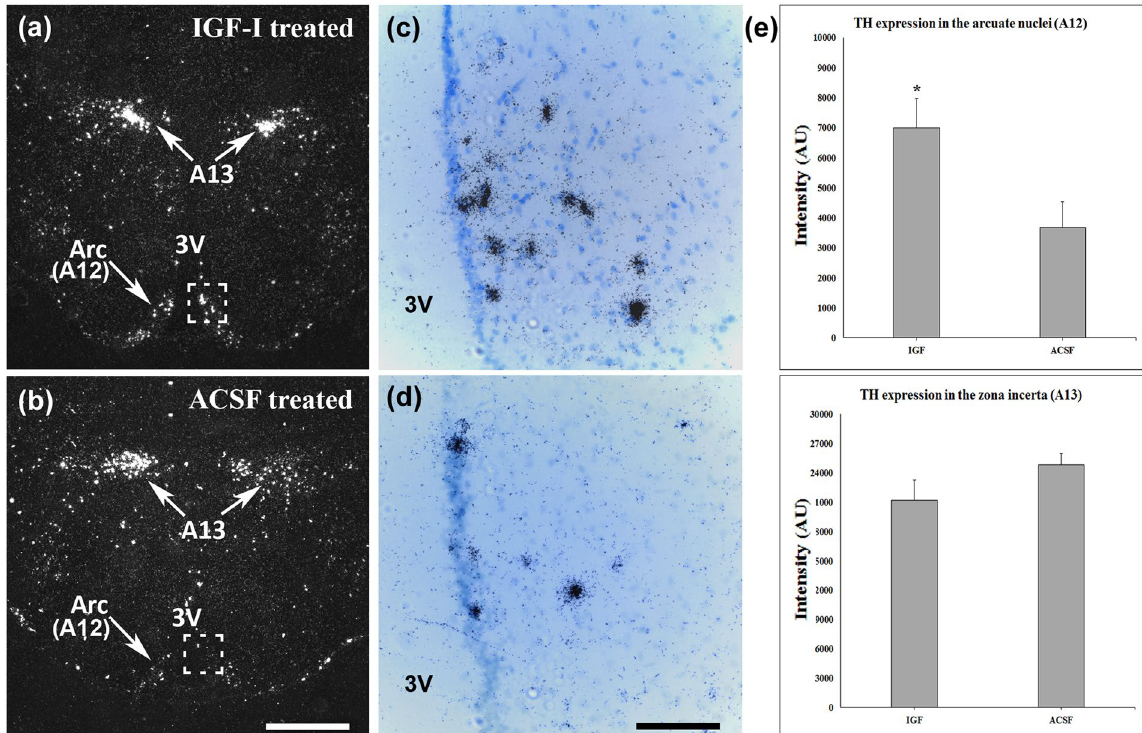
Figure 6. I.c.v. IGF-I administration enhanced the expression of TH in the arcuate nucleus. ( a,b ) The brains of IGF-I- and ACSF-treated rat mothers (n = 4 in both groups) were used for in situ hybridization histochemistry. Dark-field photomicrographs show that TH mRNA expression (white dots) was abundant in the zona incerta (A13 dopamine cell group) and the arcuate nucleus (A12 dopamine cell group) in IGF-I treated mothers. Without IGF-I, however, TH mRNA levels are low in the arcuate nucleus and are abundant in the zona incerta. ( c,d ) High magnification bright-field photomicrographs show the corresponding framed areas – the dorsomedial subdivision of the arcuate nucleus – in A and B to demonstrate increased density of individual autoradiography grains (black dots) in IGF-I-treated mothers. ( e ) Quantification of the signal in TH in situ hybridization histochemistry. The intensity in the arcuate nuclei of IGF-I treated mothers exhibited an approximate twofold increased compared with that in the ACSF-treated group (n = 6–6, * p < 0.05, p = 0.0435), while a significant difference was not detected in the zona incerta. The results are presented as the mean values ± SEM. Abbreviations: Arc – arcuate nucleus, A12–A13 – dopamine cell groups in the arcuate nucleus, and the zona incerta, respectively, 3 V – third ventricle. Scale bar = 1 mm for A and B and 100 µ m for C and